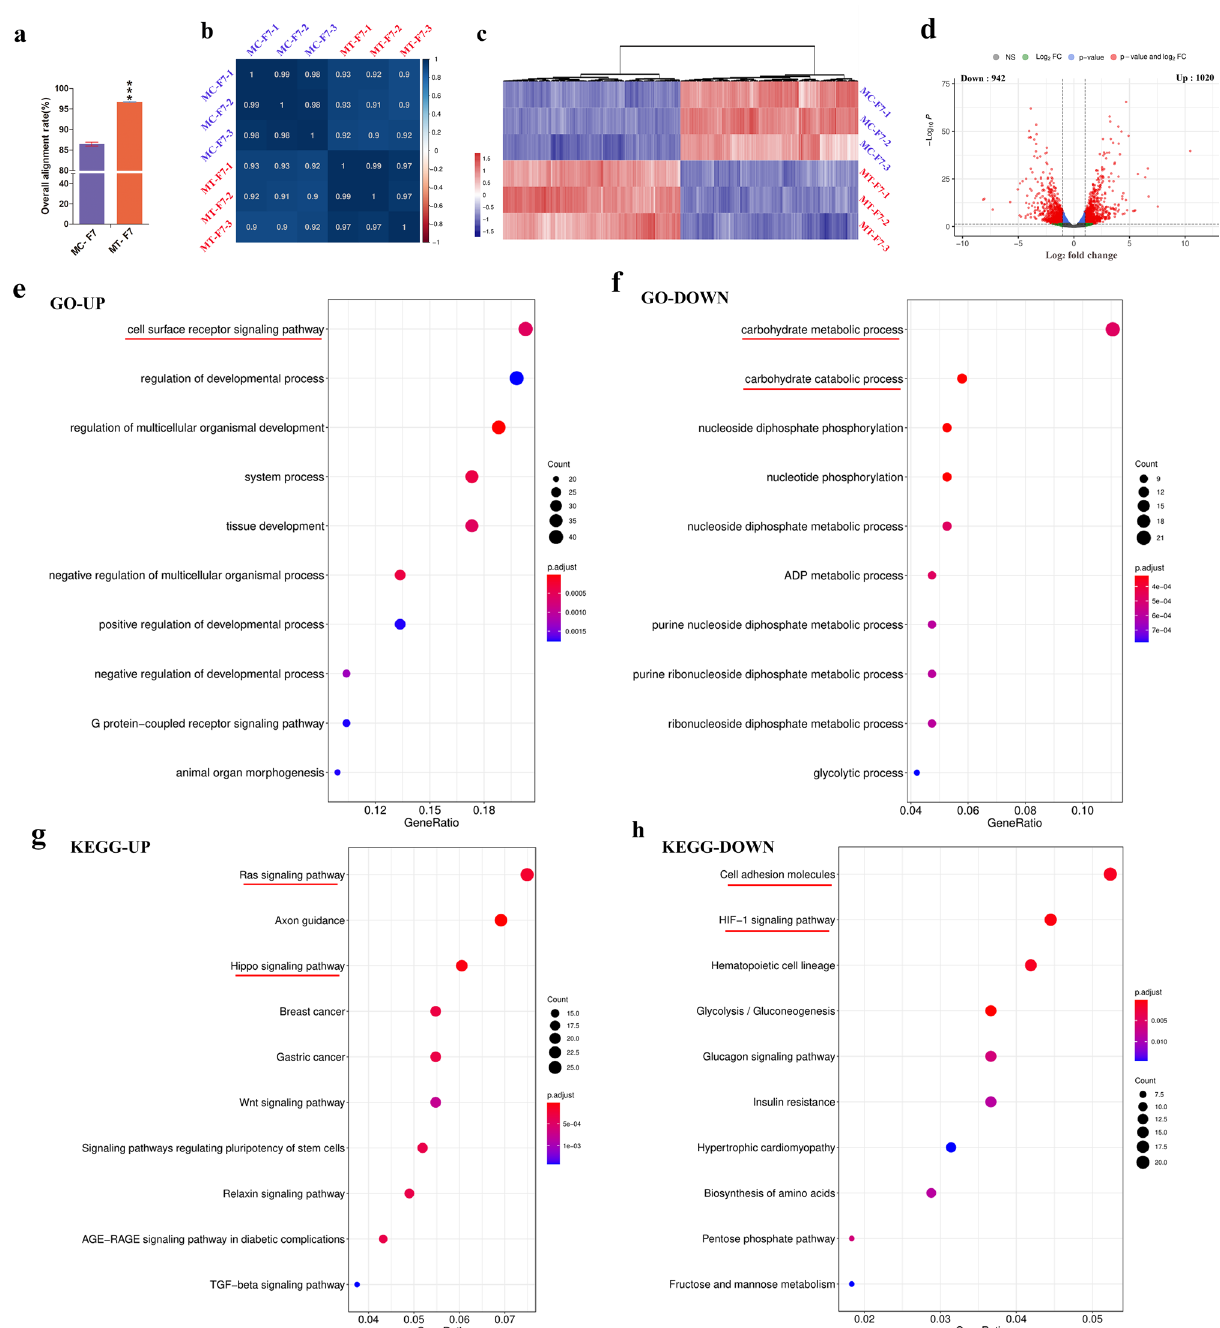
Figure 4. Global gene expression profile of MT-F7 and MC-F7 cells based on RNA-seq analysis. ( a ) The overall alignment rate of MT-F7 cells was greater than that of MC-F7 cells (96% vs. 85%). ( b ) Pearson correlation analysis showed similar global transcriptional profiles among samples of MC-F7 and MT-F7 cells. ( c ) Heatmap shows the fold changes of 1962 DEGs (|log2FC |> 1.5; P value < 0.05) in MT-F7 cells compared to the MC-F7 cells. The gene read counts were consistent between the MT-F7 and MC-F7 samples. ( d ) The volcano map shows significantly higher expression of 1020 genes and reduced expression of 942 genes in the MT-F7 cells compared to the MC-F7 cells. ( e–h ) The top 10 GO terms and KEGG pathways (up and down) based on the differentially expressed genes (DEGs) between MC-F7 and MT-F7 cells. The enriched GO terms or KEGG pathways with the most gene counts and Gene Ratio were analyzed at the genetic level (above the red